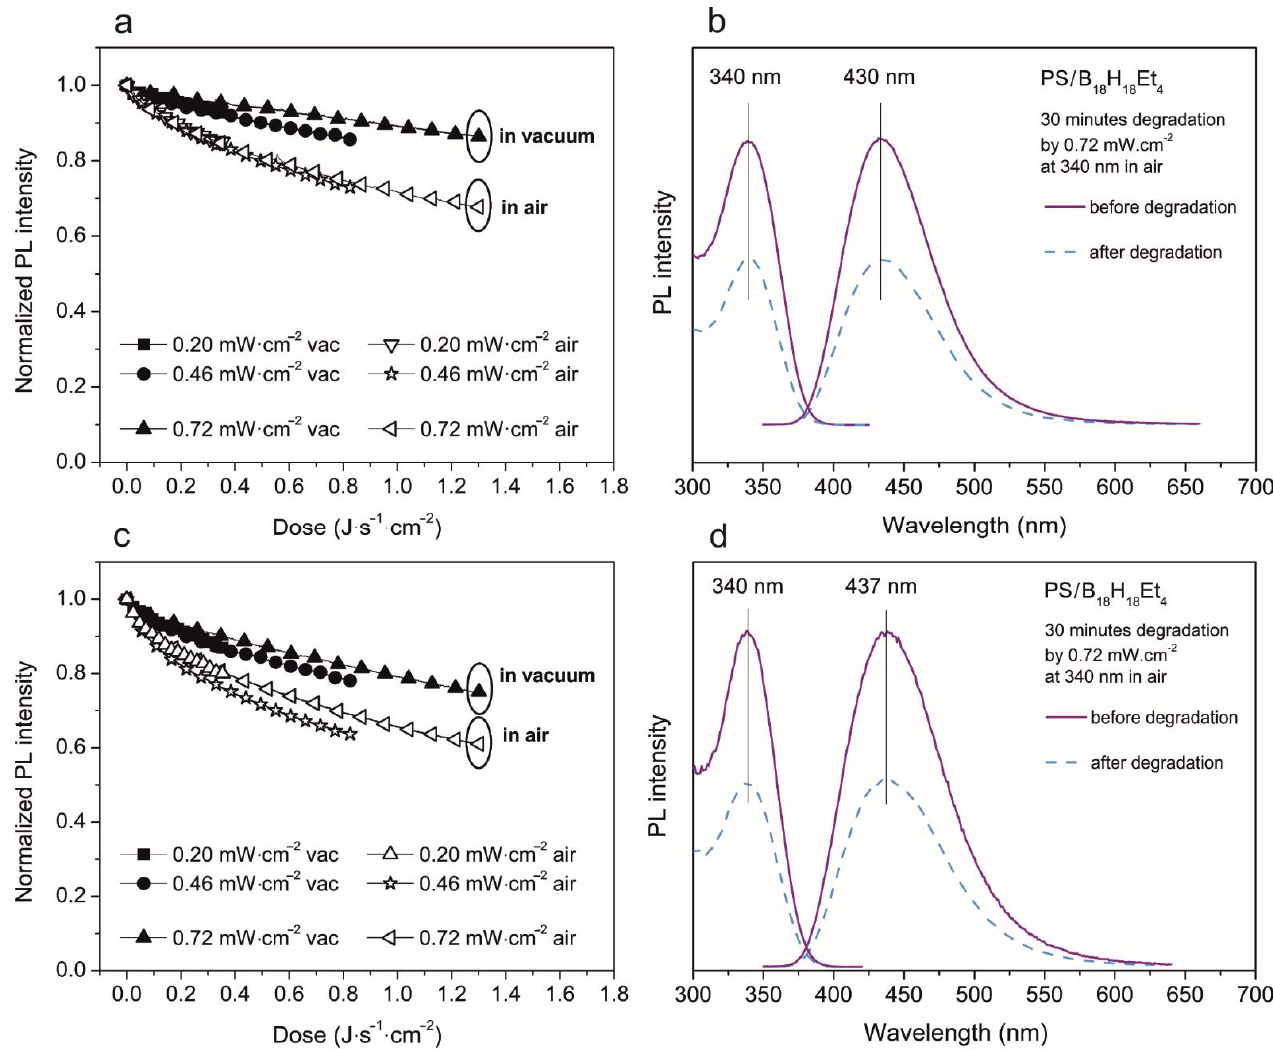
Figure 8. Photodegradation study of 750 nm ( a , b ) and 200 nm ( c , d ) thick film of PS/3,3′,4,4′-Et 4 - anti -B 18 H 18 in weight ratio 6:1. Left ( a , c )—evolution of normalized PL intensity of emission maxima in both vacuum and air environment depending on the energy dose. The excitation and emission spectra measured before and after 30 min of degradation—right ( b , d ).